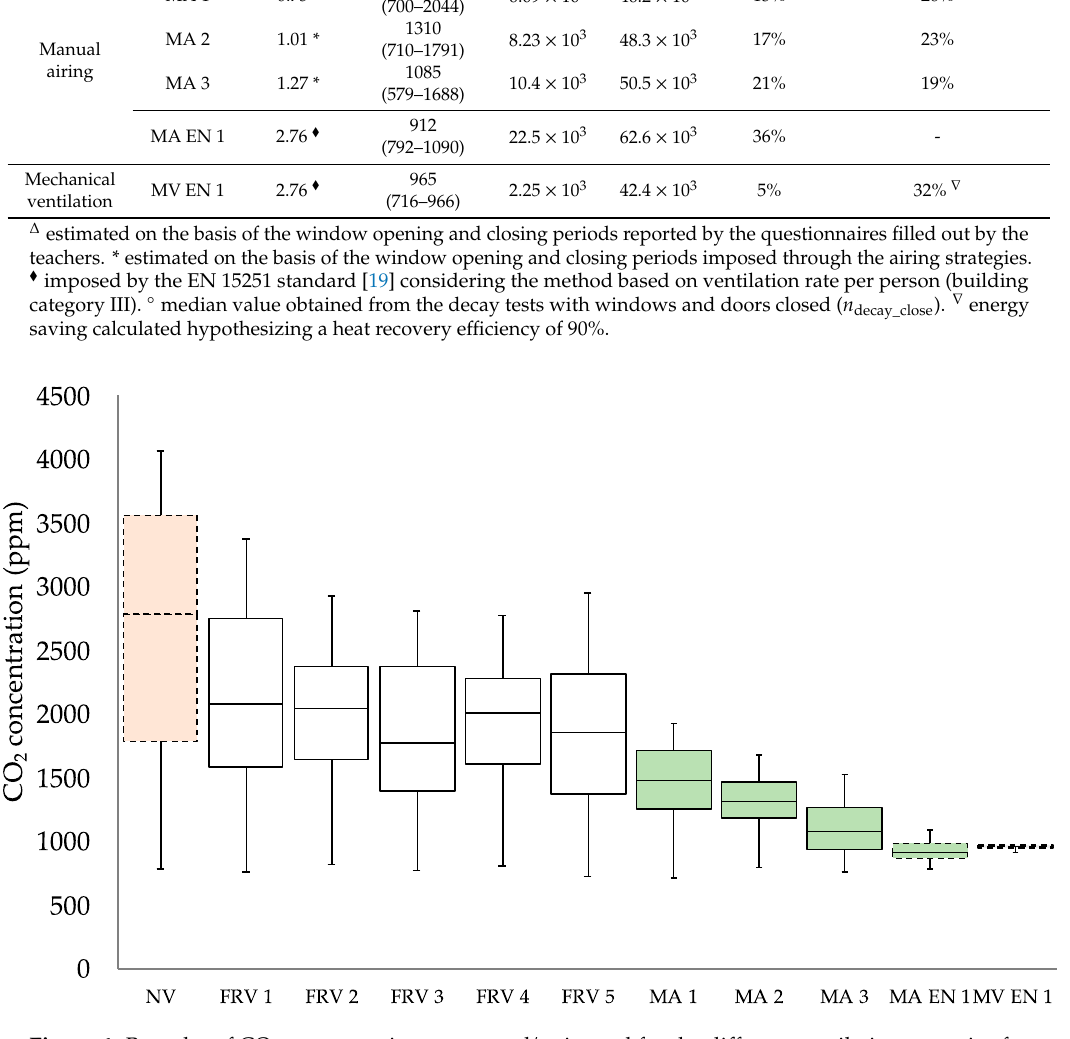
Figure 4. Box-plot of CO 2 concentrations measured/estimated for the different ventilation scenarios for the same crowding index (2.2 m 2 person − 1 ). Dashed boxes represent estimated values, whereas solid boxes are used for measured values.